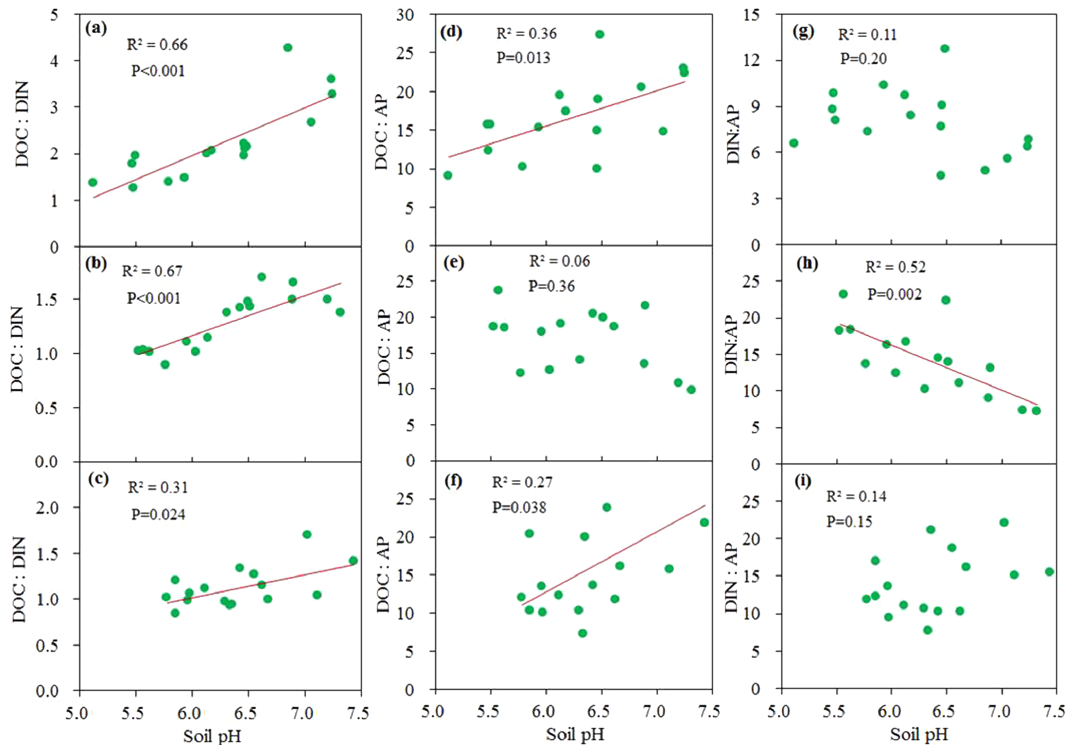
Figure 4. The relationships between soil pH and DOC:DIN within large macroaggregates (a) , small macroaggregates (b) , and microaggre- gates (c) , between soil pH and DOC:AP within large macroaggregates (d) , small macroaggregates (e) , and microaggregates (f) , and between soil pH and the DIN:AP ratio within large macroaggregates (g) , small macroaggregates (h) , and microaggregates (i) . The significance level was set at P